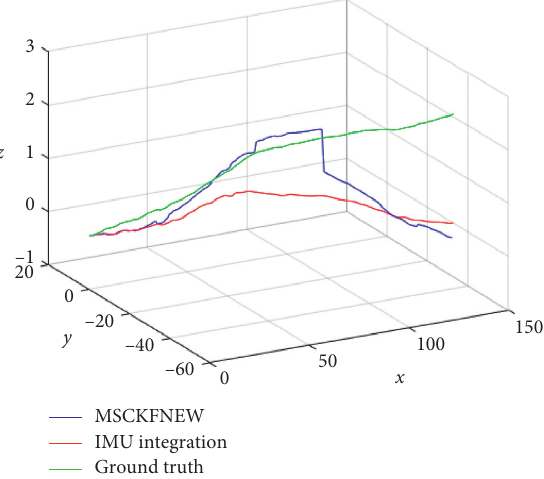
Figure 4: The trajectories of improved MSCKF with No. 2